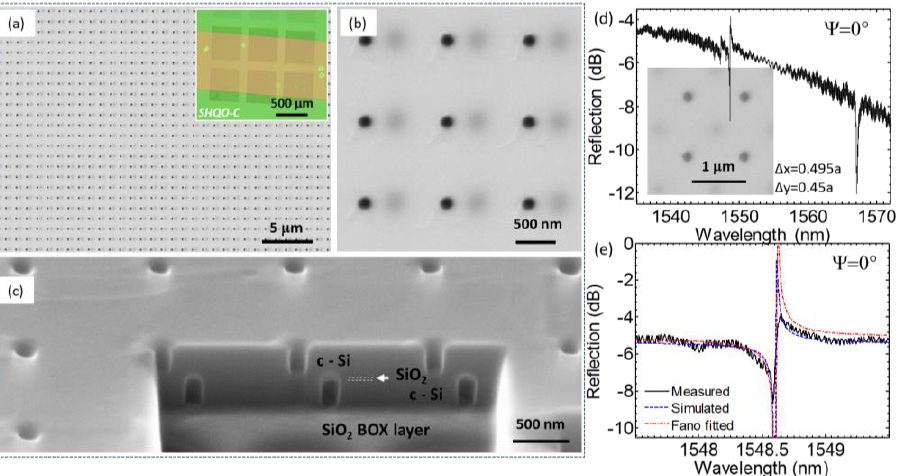
Figure 7. Fabricated double layer 2D PCS. ( a ) Top view SEM image; ( b ) Zoom-in view; ( c ) Cross-sectional view; ( d ) Measured reflection spectrum of a large offset; and ( e ) Zoom in plots around the dominant resonance with measured, simulated, and Fano fitted reflection spectra. Reproduced with permission from [43].